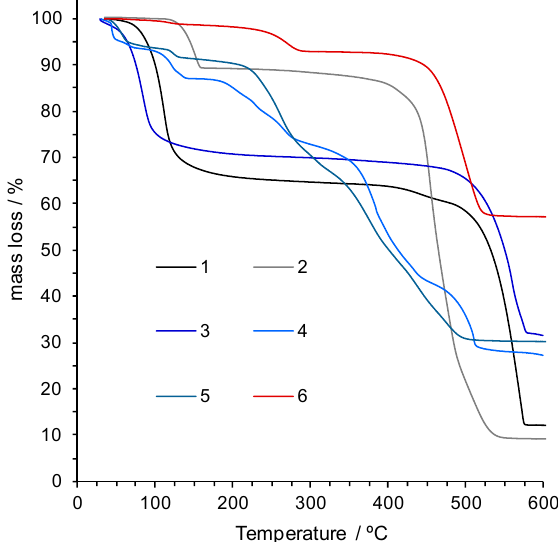
Figure 8. TGA profiles of the materials 1 – 6 between 30 and 600 ° C with a heat rate of 5 ° C/min in a 20 cm 3 /min air flow stream.